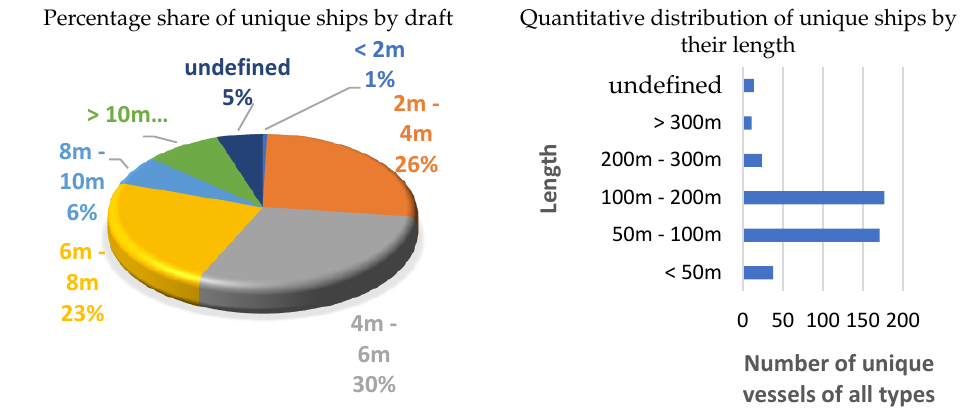
Table 10. Qualitative characteristics of all types of ships. Percentage share of unique ships by draft